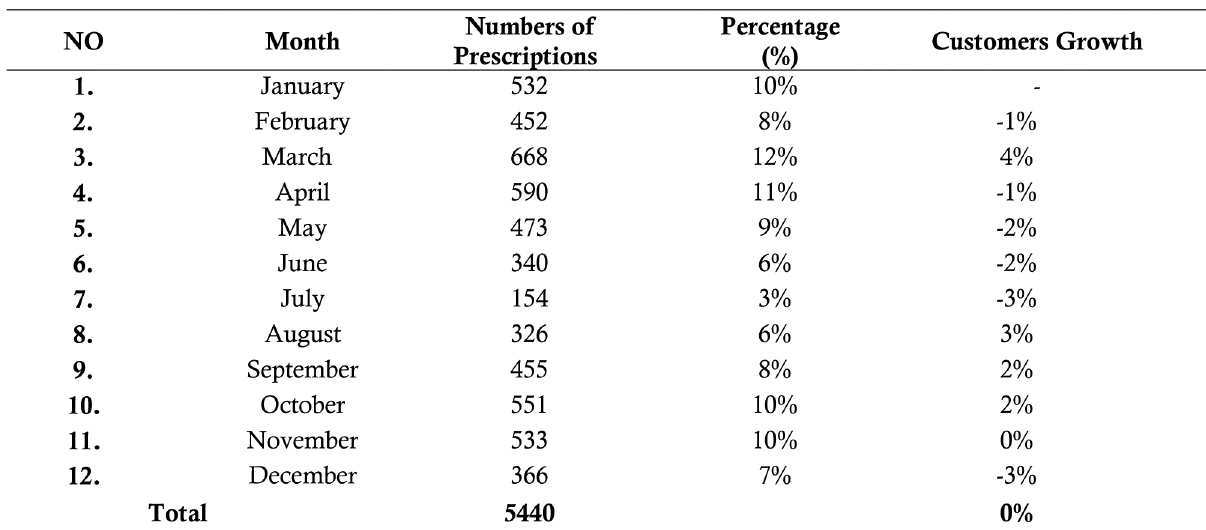
Table 5. Measurement Result of Customers Growth in UMC Pharmacy year